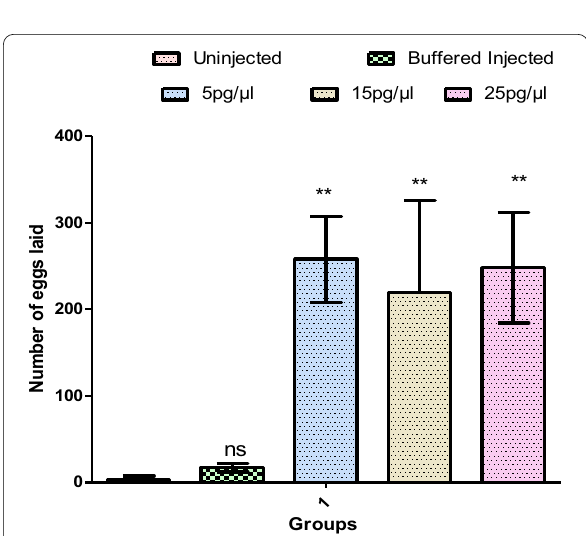
Fig. 5 Number of eggs laid by Spodoptera litura females followed by injection with different concentrations of recombinant protein in comparison with controls ( n =